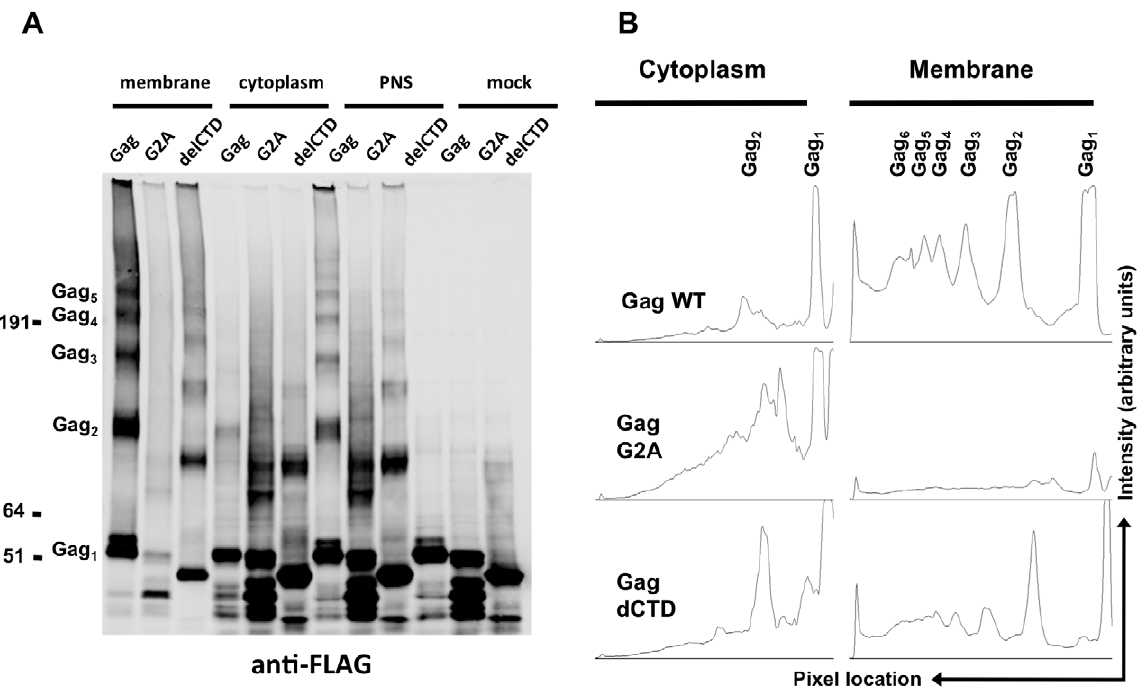
Figure 5. Multimerization of Gag, G2A-Gag, Gag-delCTD in plasma membrane and cytoplasm. 293T cells coexpressing FLAG and HA- tagged Gag or its derivatives (G2A-Gag or Gag-delCTD) together with V1B-MS2 viral RNA were cross-linked by treatment with 1mM EGS and used in membrane flotation assay. ( A ) Western blot analysis of Gag, G2A-Gag and Gag-delCTD in membrane fractions (lanes 1–3), cytoplasmic fractions (lanes 4–6), post-nuclear supernatants (PNS, lanes 7–9) and in mock crosslinked post-nuclear supernatants (lanes 10–12) using mouse anti-FLAG antibodies. ( B ) Quantitative analysis of membrane (lanes 1–3) and cytoplasmic (lanes 4–6) fractions of the western blot in (A). x -axis shows the pixel location and y -axis indicates the average pixel intensity in the lane that is analyzed. Degree of Gag multimerization is marked by subscripts (i.e. Gag 3 corresponds to Gag trimers).